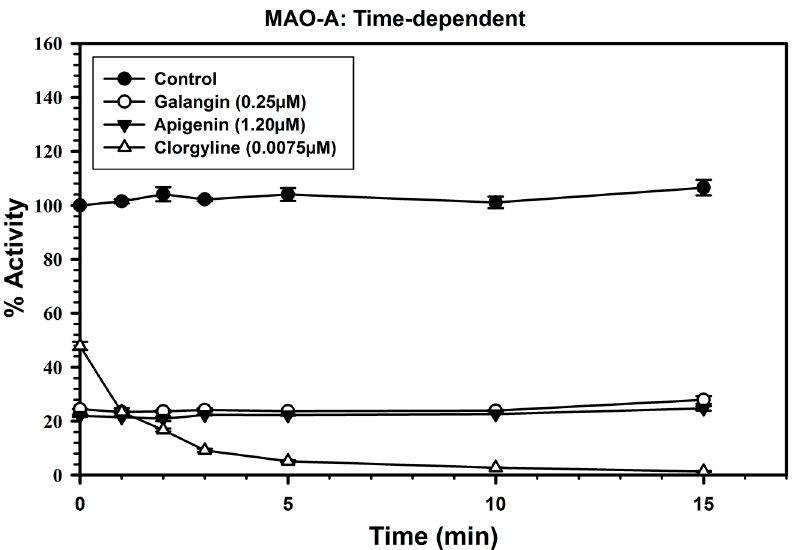
as % of activity. Each point represents mean ± S.D. of triplicate